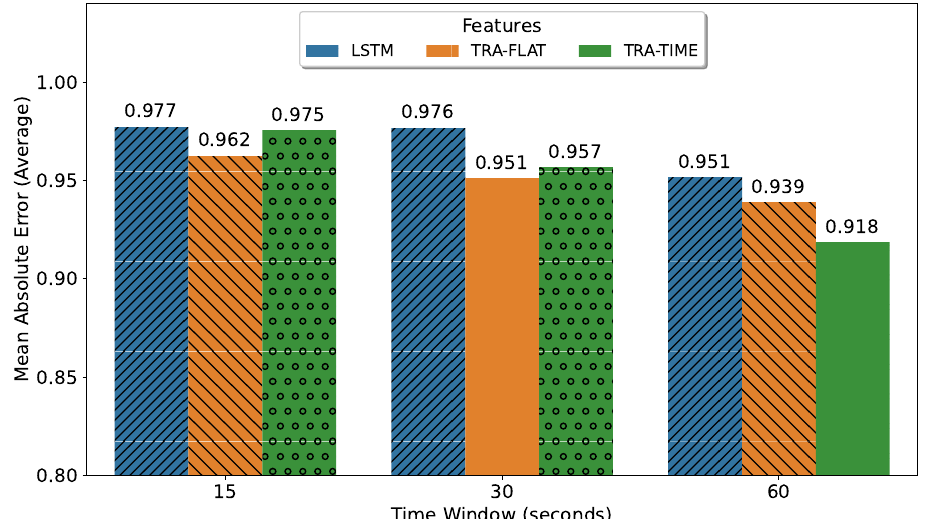
Figure 5. Comparison of the most efficient multi-horizon architectures and input time-window sizes in terms of the average mean absolute error (MAE) across all predicted steps. The performance of all architectures improved as the input time-window size increased while using only the guide error as the input feature. The best performing architecture, with an MAE of 0.918, was the transformer with attention to time features only (TRA-TIME) using a 60 s input time